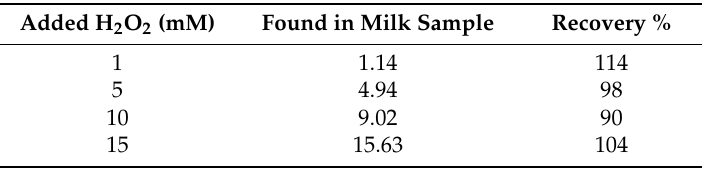
Table 2. Recovery of the milk sample for the Hb/TiAu-APTS biosensor in H 2 O 2 detection ( n = 3) with RSD =